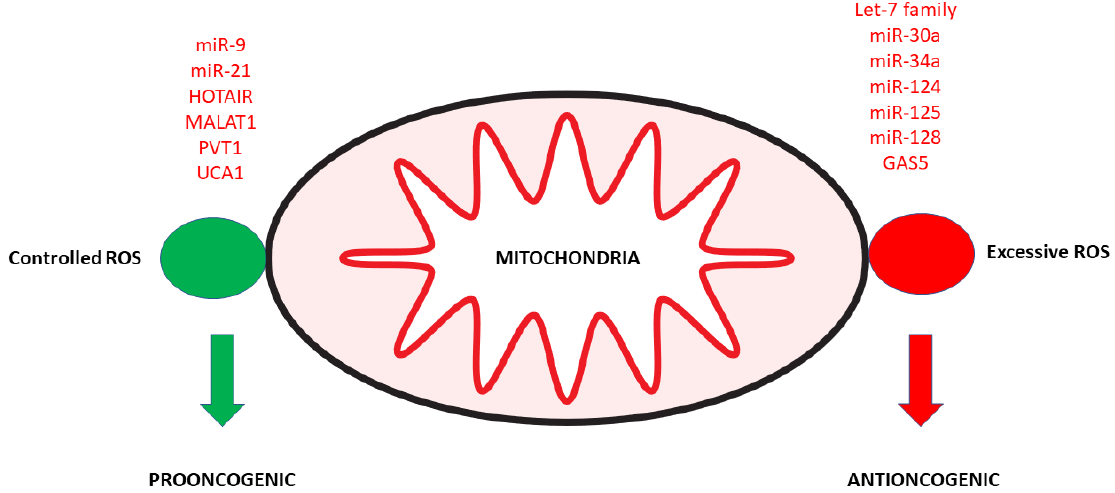
Figure 1. Noncoding RNAs and mitochondrial function and oxidative stress. Controlled release of ROS is required to entertain tumor growth, while excessive ROS production leads to cell death. Upregulated noncoding RNAs are in red.